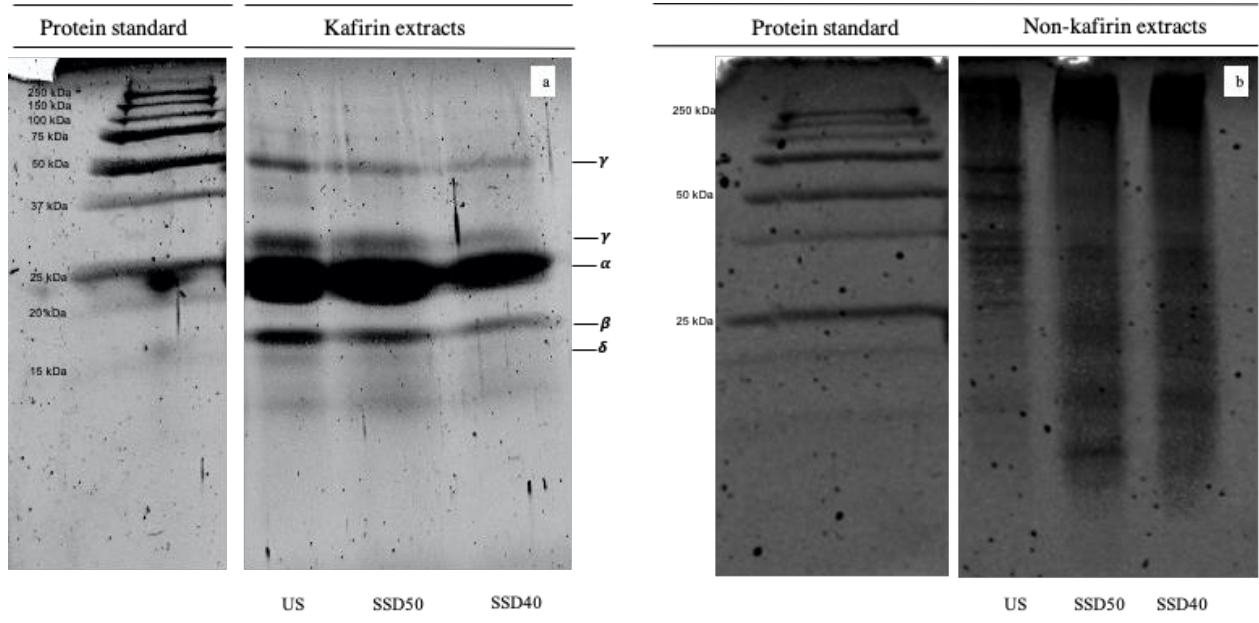
Figure 1. Sodium dodecyl sulfate polyacrylamide gel electrophoresis (SDS-PAGE) of kafirin ( a ) and non-kafirin ( b ) fractions of sorghum flours. US, unsprouted sorghum flour; SSD50, flour from sprouted sorghum dried at 50 °C for 6 h; SSD40, flour from sprouted sorghum dried at 40 °C for 12 h.